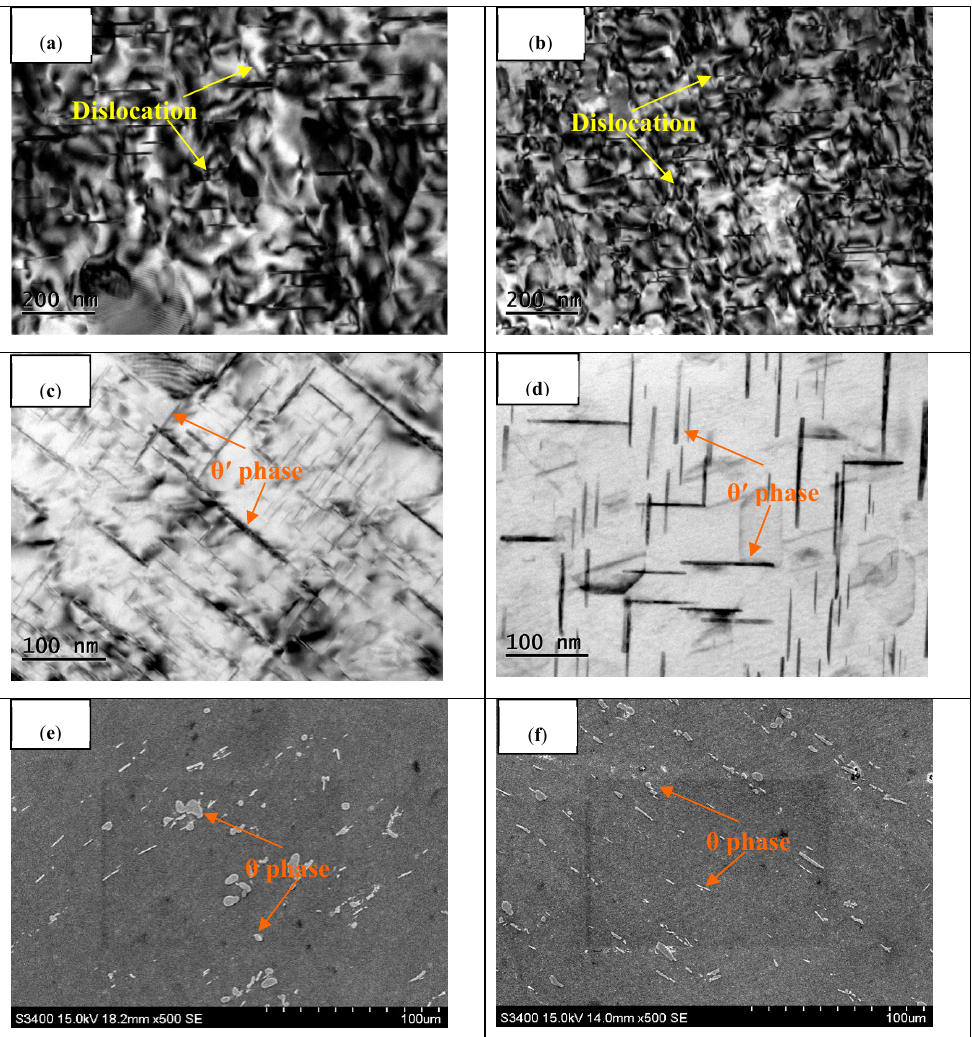
Figure 10. Microstructure evolution of 2219 aluminum alloy for as-cast and homogenized sample with or without T6 treatment after forging, ( a , b ) TEM micrographs of as-cast ( a ) and homogenized ( b ) sample after forging; ( c , d ) TEM micrographs of as-cast ( c ) and homogenized ( d ) sample with T6 treatment after forging; ( e , f ) SEM micrographs of as-cast ( e ) and homogenized ( f ) sample with T6 treatment after forging.